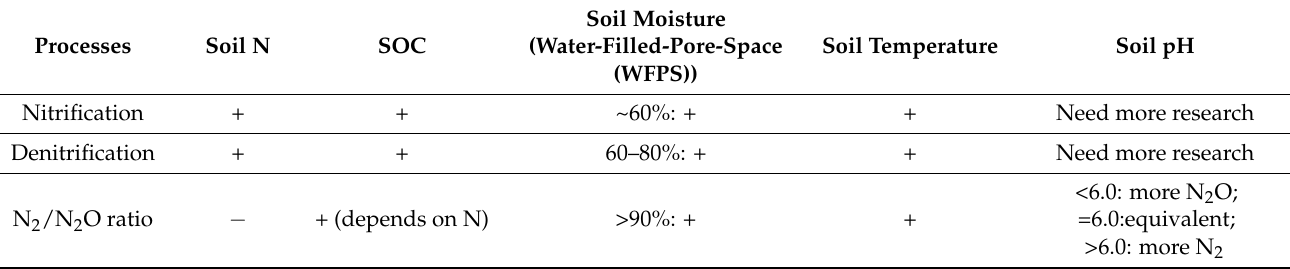
Table 2. The relationships between environmental factors and N 2 O